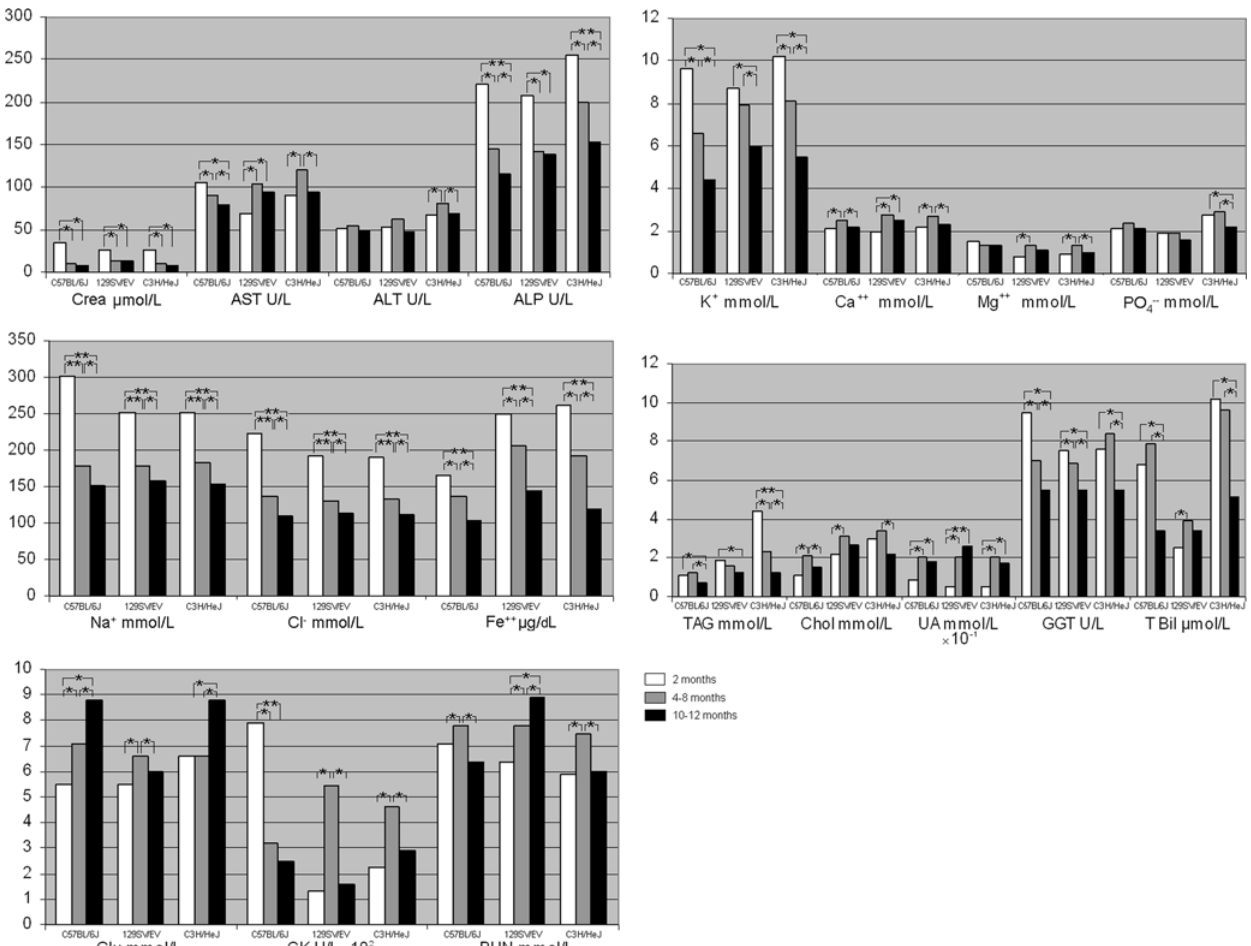
Figure 2. Biochemical median values in female mice. Age related biochemical median values calculated in C57BL/6J, 129SV/EV and C3H/HeJ mouse strains. Statistical significant differences among values observed in the three age-period (2/ 4–8/ 10–12 months) are also indicated: * p , 0.05, ** p , 0.001.